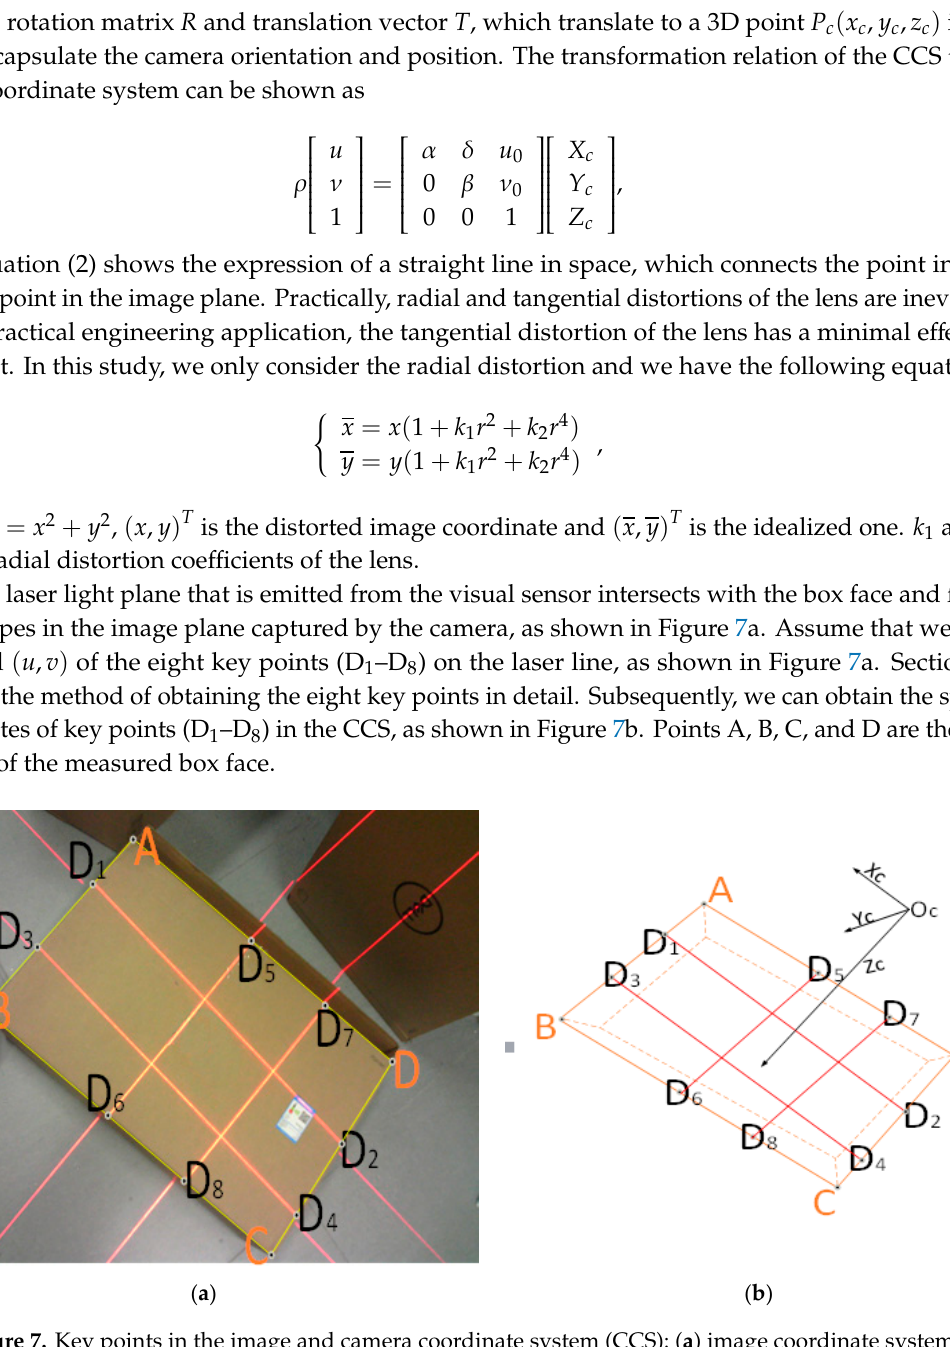
Figure 7. Key points in the image and camera coordinate system (CCS): ( a ) image coordinate system, and ( b ) CCS.